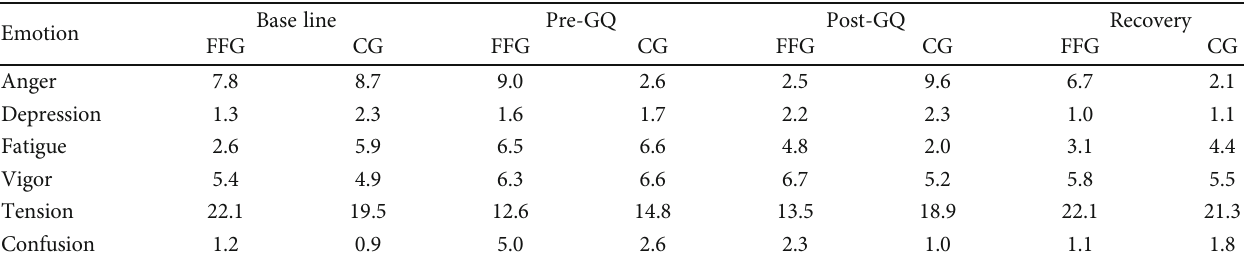
Table 1: Matching table of the fi ve elements of music.